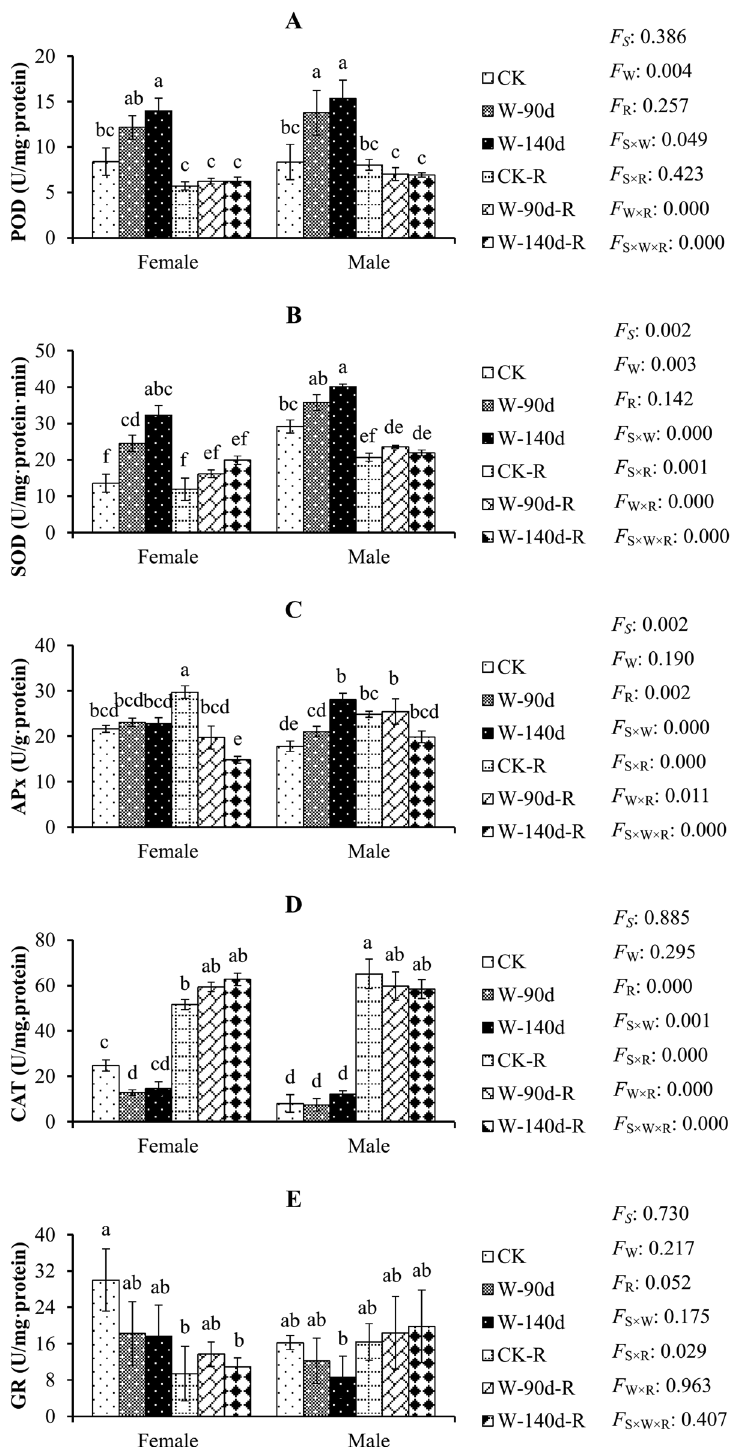
Figure 6. Peroxidase (POD), superoxide dismutase (SOD), ascorbate peroxidase (APx), catalase (CAT), and glutathione reductase (GR) activity variations in male and female P. deltoides under winter flooding stress and post-flooding recovery. CK, control treatment; W, flooding and waterlogging stress treatment; R, recovery after waterlogging stress. Values are means ± SE ( n = 5). Values followed by different little letters are significantly different at P < 0.05 according to Duncan’s test. The significance values of the factorial analysis (ANOVA) for: F S , F W , and F R refer different effects of species, watering, and recovery growth, respectively; F S × W , F S × R , F W × R , and